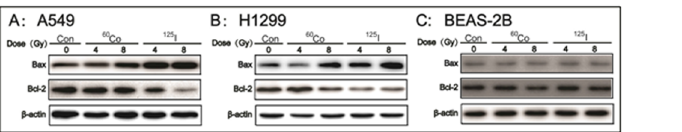
Fig 4. The expression of Bcl-2 and BAX proteins in A549, H1299 and BEAS-2B cells after exposure to 125 I seeds CLDR radiation and 60 Co γ -ray HDR radiation of 4 and 8 Gy. One representative result of three independent experiments with identical results is shown. Con: control.